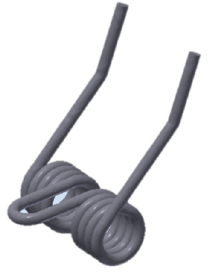
Figure 4. Spring tooth.